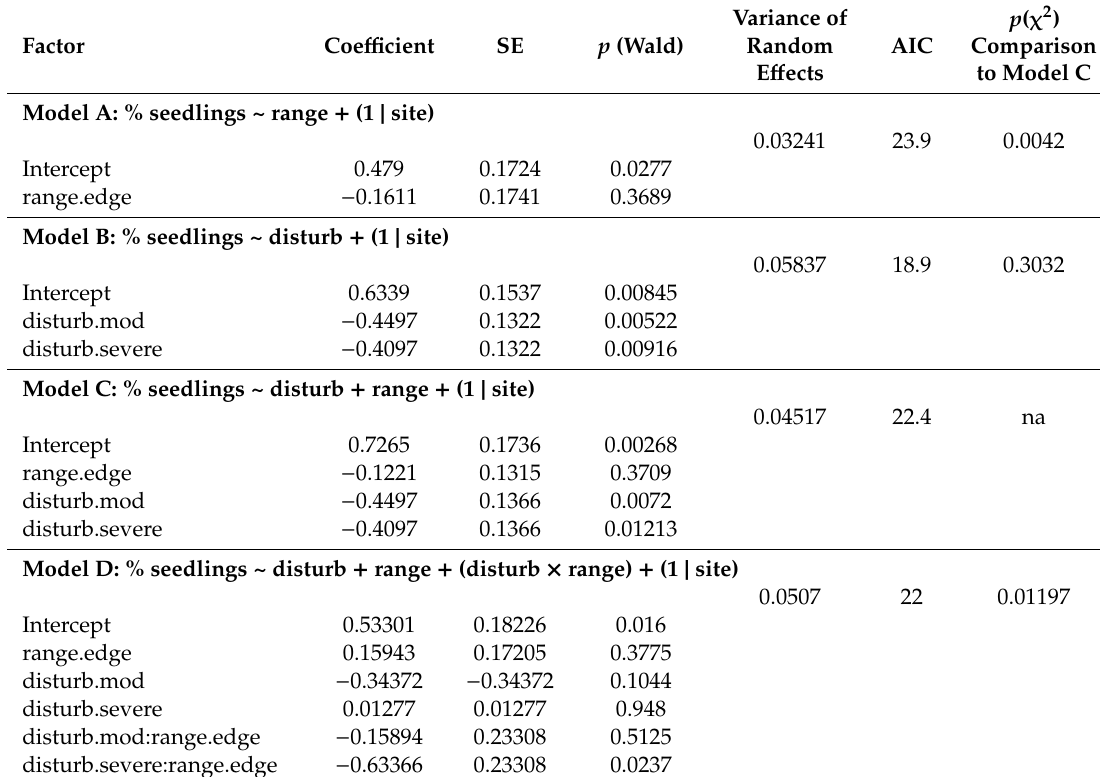
Table 3. Whitebark pine seedling proportion (%) results for Study #2 generalized linear mixed models (GLMM). Explanatory variables (disturbance and range position) are factors. Those with multiple levels are assigned codes representing predicted values from each baseline category, where intercepts represent the first category. Estimated coe ffi cients, standard errors (SE), and p -values for Wald tests are shown for each variable. Akaike Information Criteria (AIC) are given, plus log-likelihood ratio test results comparing Models A, B, and D to Model C to isolate the significance of each variable. Disturb = disturbance level; range = range position; and site = study